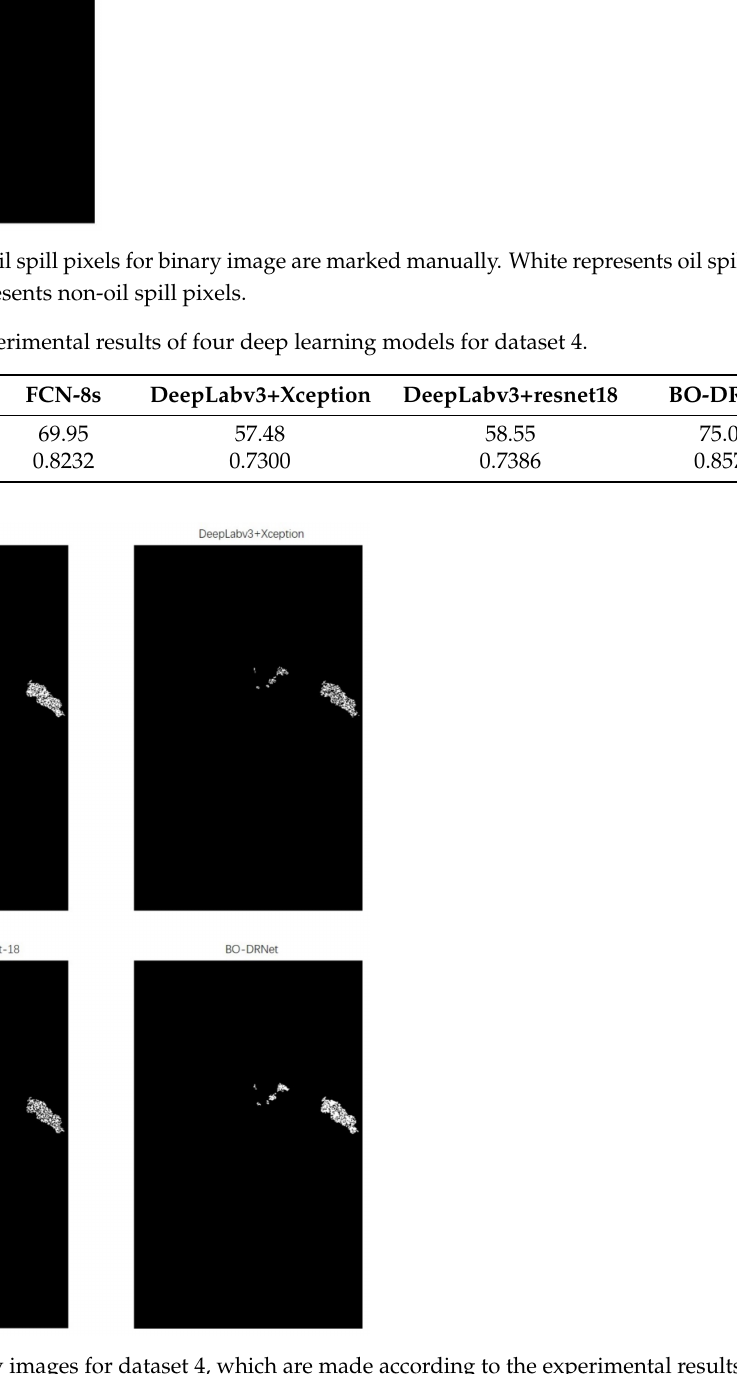
Figure 12. Binary images for dataset 4, which are made according to the experimental results of four deep learning models. White represents oil spill pixels, while black represents non-oil spill